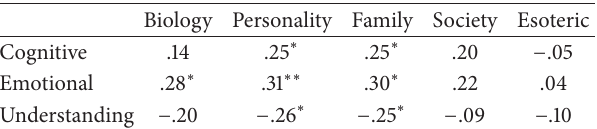
Table 2: Pearson correlations between illness perception dimen- sions (Brief-IPQ) and illness attribution categories (Angermeyer and Klusmann Scale) ( 𝑁 = 62).